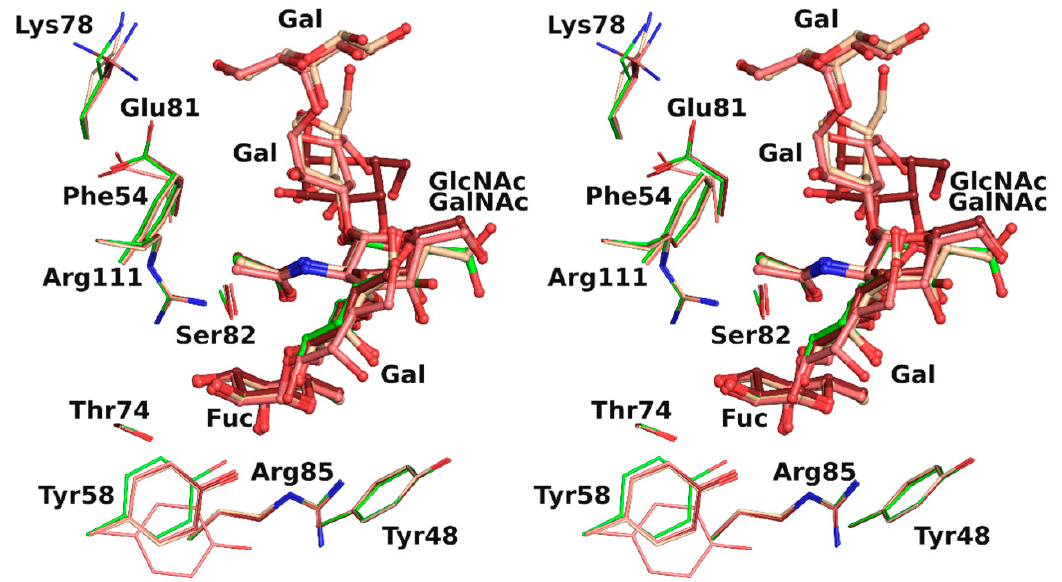
Figure 4. Overlay in wall eye stereo of each binding site observed in rBC2L-CN2 structure with H-type 1 (green) or Globo H (H-type 3) with carbon atoms colored in dark red, beige, and pink for chain A, B, and C, respectively.